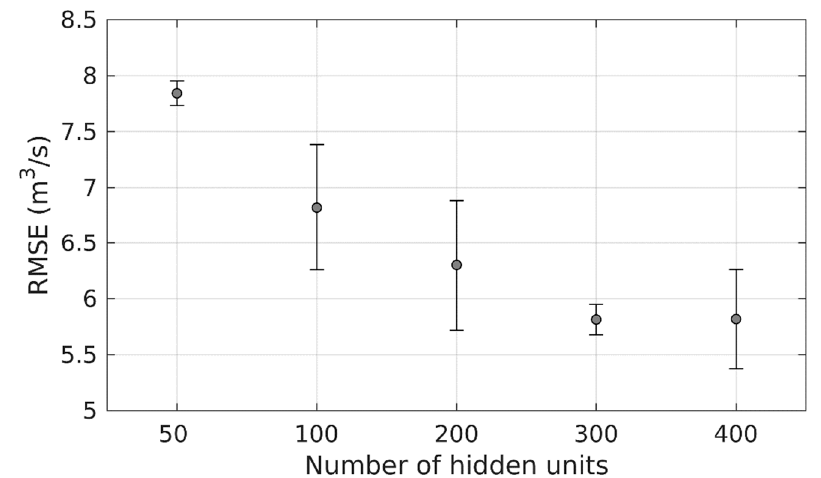
Figure 9. RMSE of a Maipo en el Manzano validation subset as a function of the number of hidden units in the LSTM layers for the DL model.